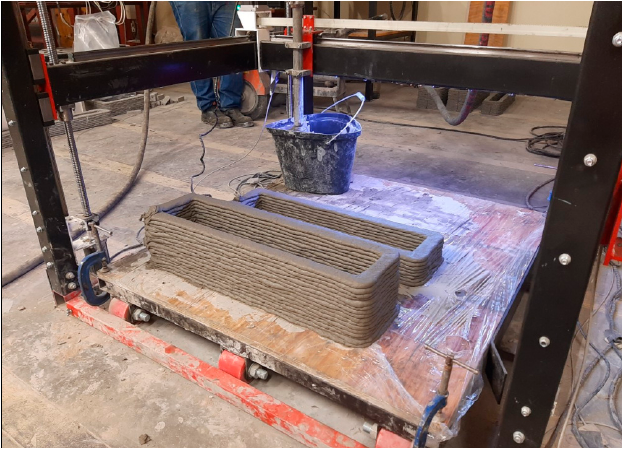
Figure 2. Stellenbosch University Gantry type 3D concrete printer of 1 m 3 build